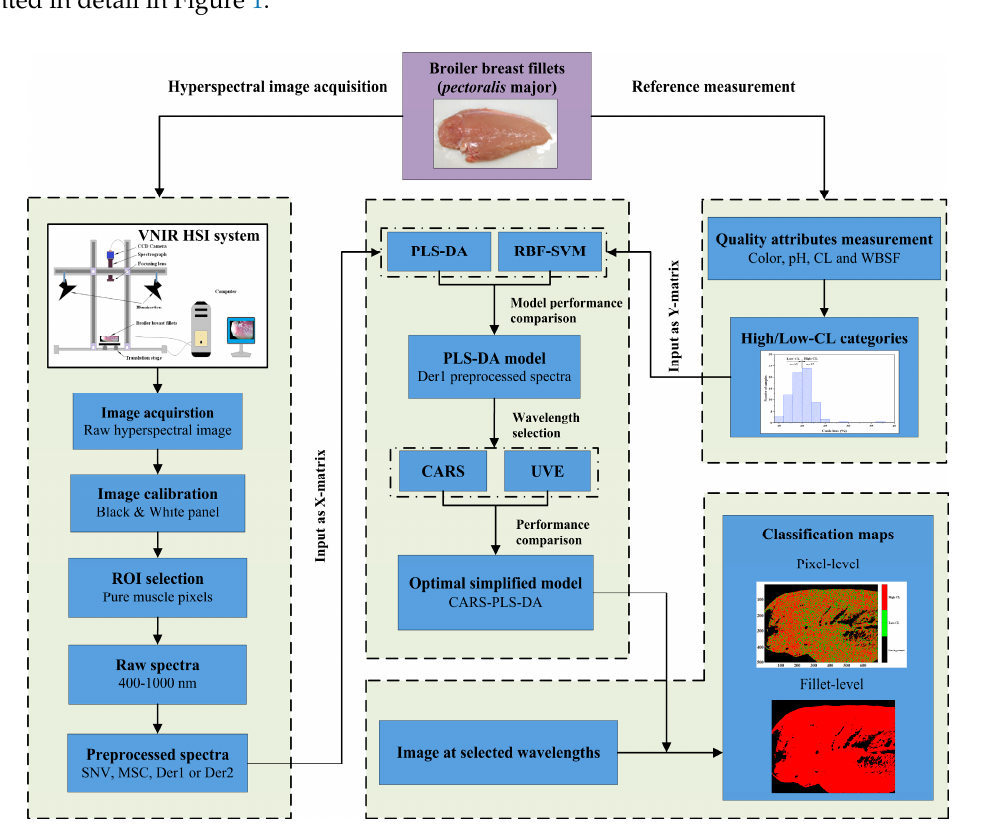
Figure 1. Main steps for experimental procedure and CL analysis of broiler breast meat by VNIR